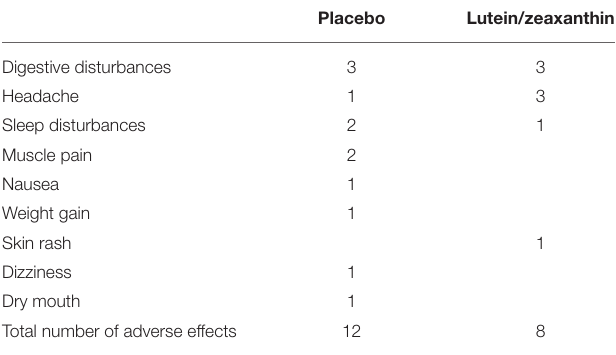
TABLE 7 | Frequency of self-reported adverse events. Placebo